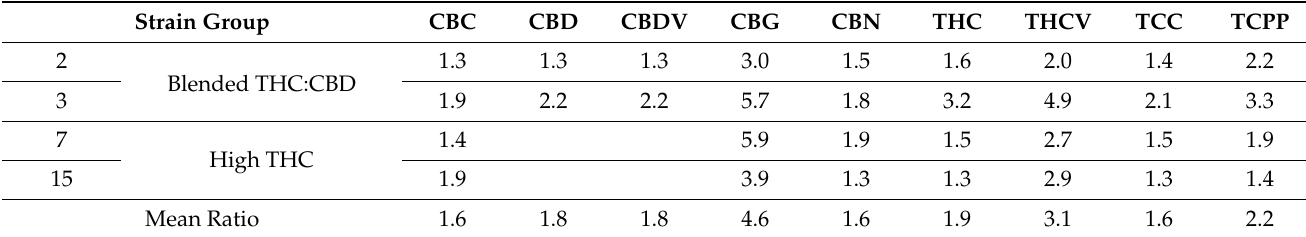
Table 2. Ratios between the highest and the lowest cannabinoid concentrations within each strain group. Strain group indices correspond with those presented in Figures 2 and 4.